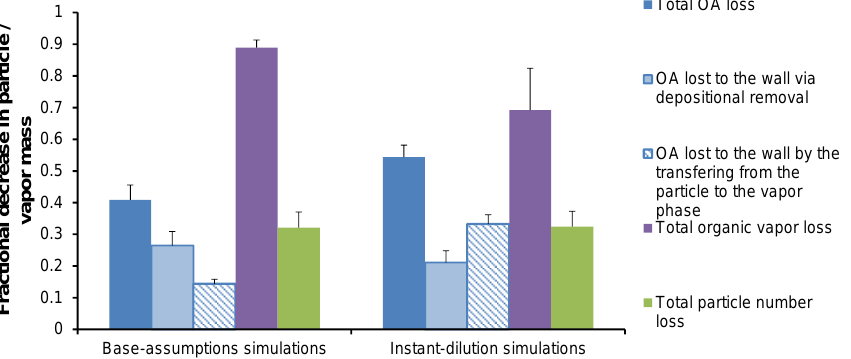
Figure 13. The organic species mass budgets and total number net loss for the base-assumption simulations and instant-dilution simulations. See Fig. 3b for a full